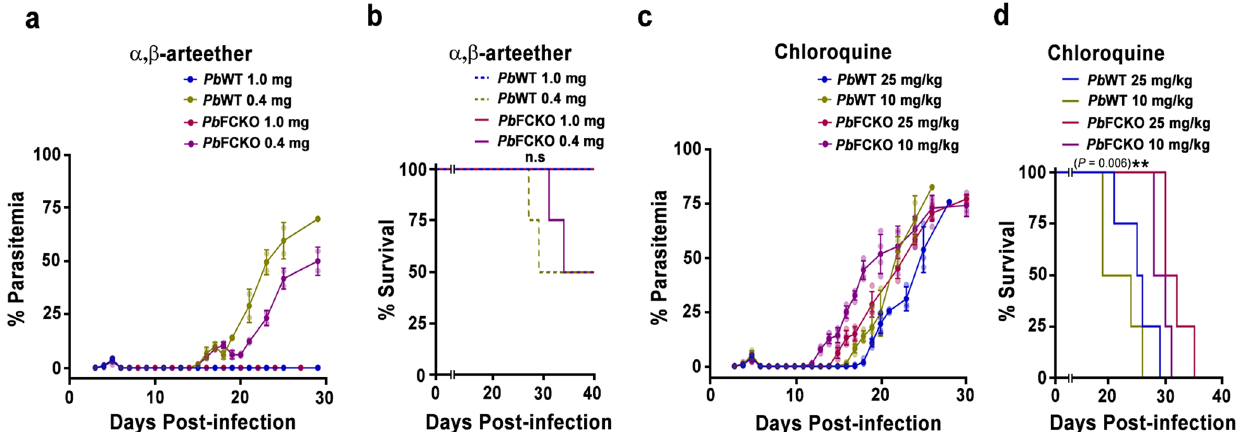
Fig. 6 Sensitivity of WT and FCKO parasites to α , β -arteether and chloroquine. a , b Blood parasitemia and mortality curves of infected mice treated with α , β -arteether, respectively. The data represent four mice for each group (n.s not signi fi cant, log-rank (Mantel – Cox) test). c , d Blood parasitemia and mortality curves of infected mice treated with chloroquine, respectively. The data represent four mice for each group (** P < 0.01, log-rank (Mantel – Cox) test). For ( a , c ), the data represent mean ± SD. Individual data points are shown with the respective light shaded colors. Source data are provided as a Source Data fi